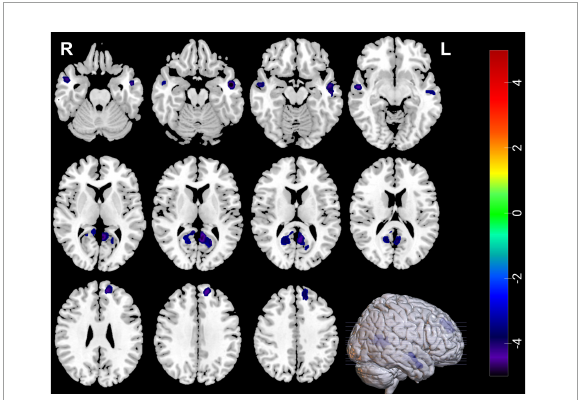
FIGURE1 Blue regions mean decreased GMVs in the left middle temporal gyrus, right superior temporal gyrus, right middle temporal gyrus, left precuneus, right precuneus, and left superior frontal gyrus of MDDs compared with HCs (GMV voxel was p < 0.001; the significance level was p < 0.05 with GRF